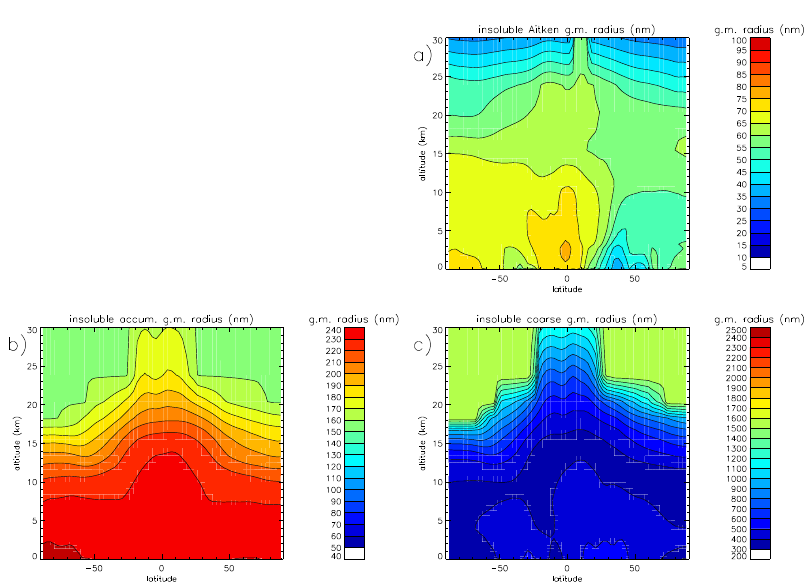
Fig. 16. Latitude-altitude plots of simulated zonal-means of annual-mean particle geometric mean radius for (a) Aitken-insoluble mode, (b) accumulation-insoluble mode and (c) coarse-insoluble